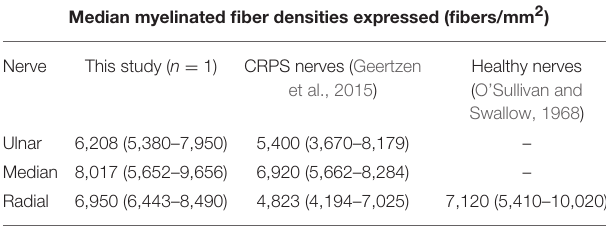
FIGURE 2 | Light microscopy of a nerve fascicle from the distal ulnar nerve sample (bar represents 50 µ m). The perineurium and endoneurium are visualized. The circle indicates a cluster of healthy myelinated axons. Arrows indicate examples of degenerating fibers. Degenerative features included myelin breakdown and collapsed nerve fibers. Stain: toluidine